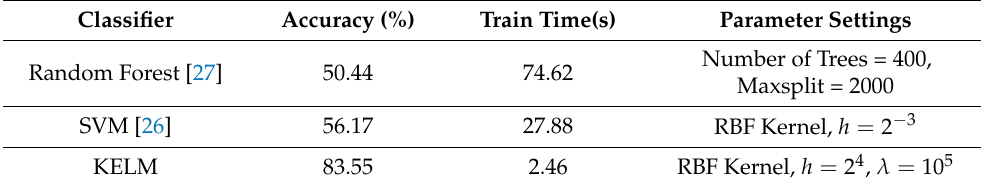
Table 4. Classification accuracy with all 10 motion trackers.